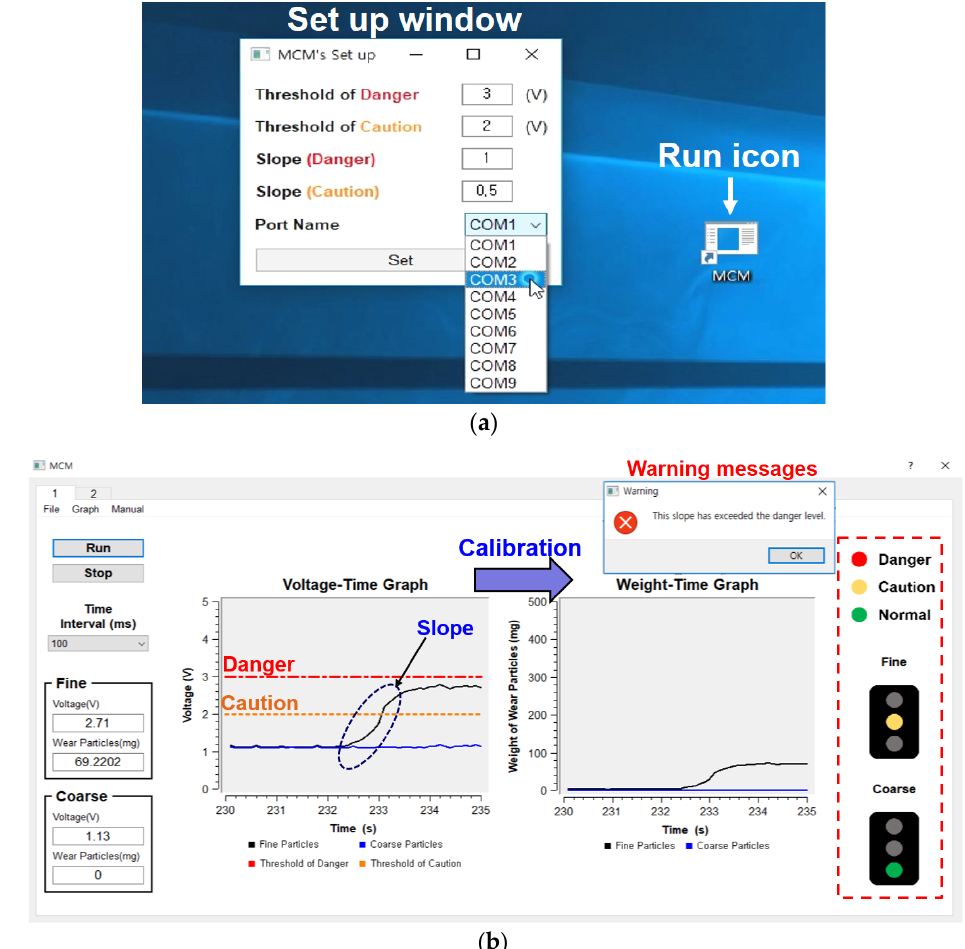
Figure 9. Diagnostic program: ( a ) Set-up window; ( b ) Main window. Of the two graphs on the main screen, the graph on the left shows the measured voltage signals for the fine and coarse particles; here, the solid black and blue lines repre- sent the voltage signals for the fine and coarse particles, respectively. Moreover, the or- ange dotted and red dash-dot lines indicate the thresholds for the caution and danger conditions, respectively. The graph on the right shows the weights of the fine and coarse particles; the voltage signals were converted to the weights of the particles using Equa- tions (1) and (2). The program provides a warning when the measured values exceed the given thresholds. The warning system indicates the condition through a message or cor- responding color, similar to a traffic light. The conditions were largely divided into three stages: normal (green), caution (yellow), and danger (red). For example, when the fine